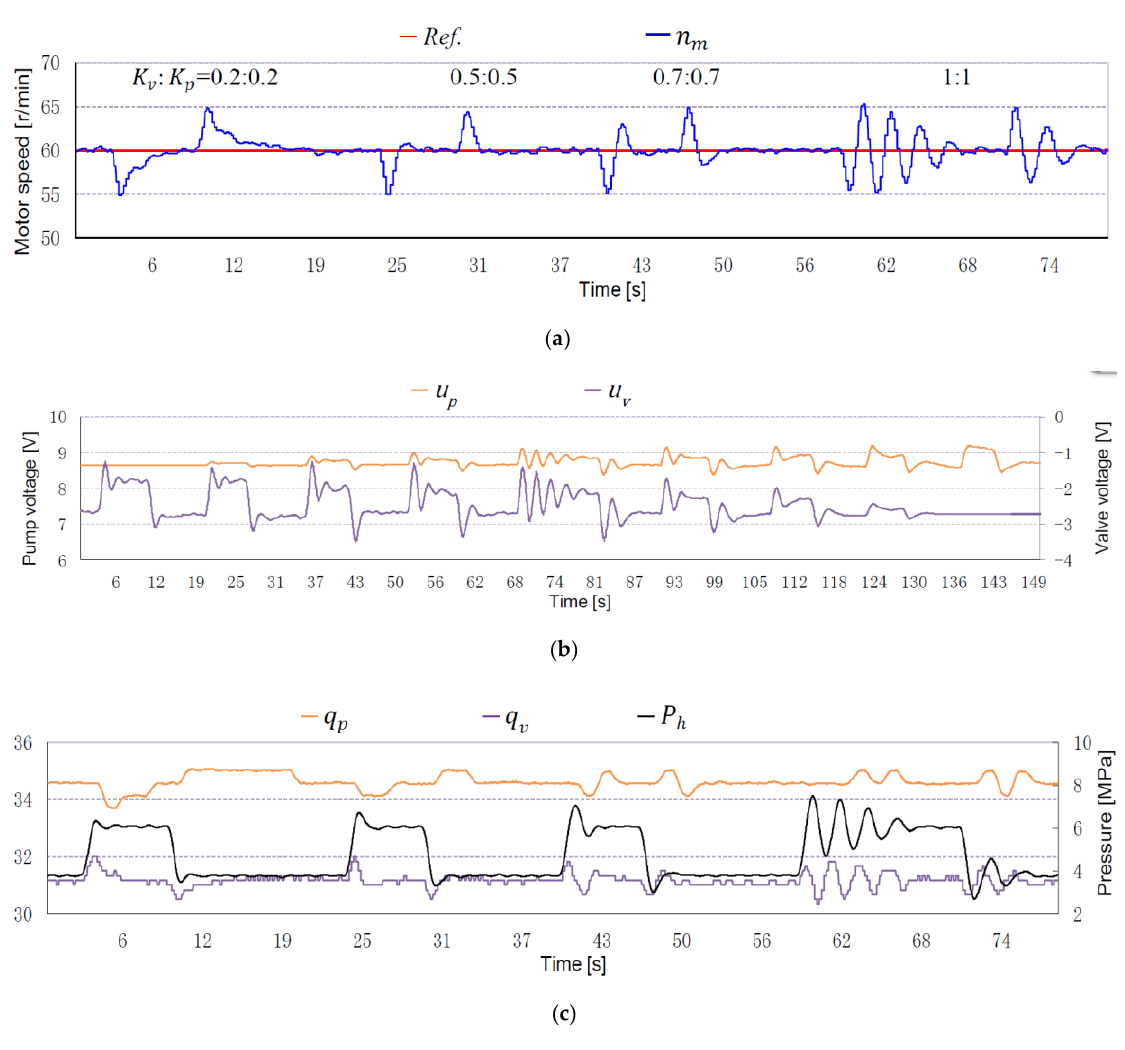
Figure10. Step response to loads when 𝐾 𝑣𝑝 = 1 . ( a ) Motor speed response; ( b ) Pump and valve voltage variation; ( c ) System pressure and flow